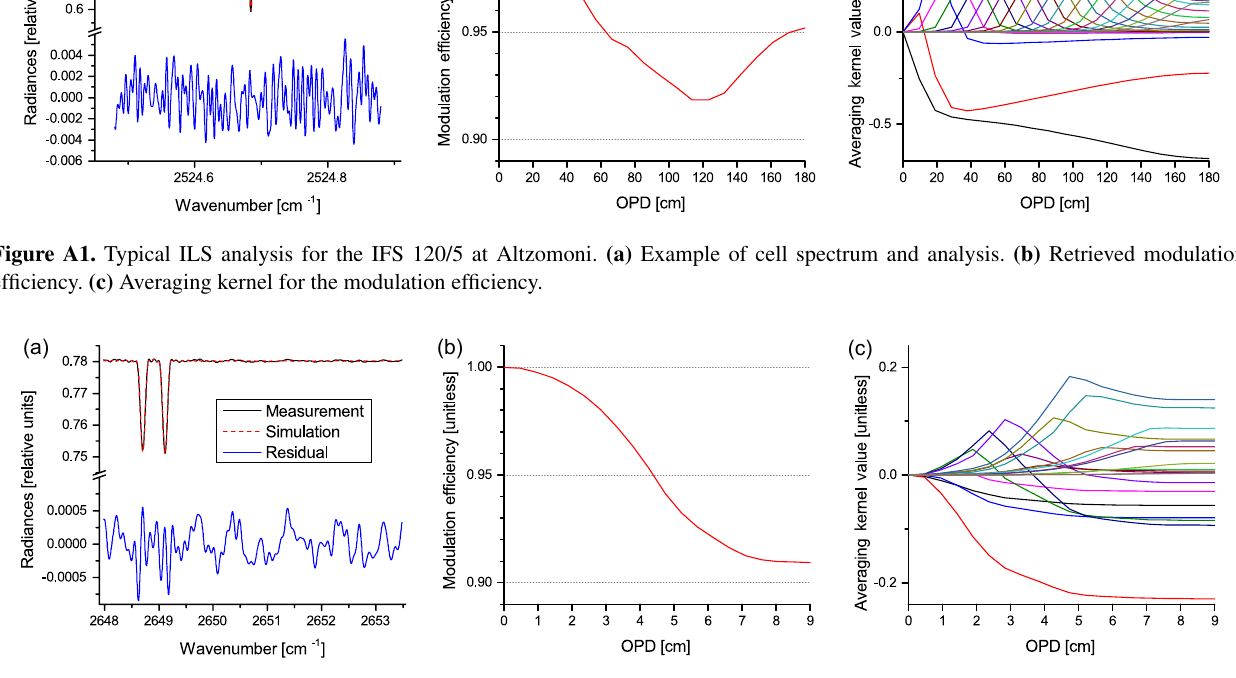
Figure A2. Same as Fig. A1, but for the Vertex 80 at